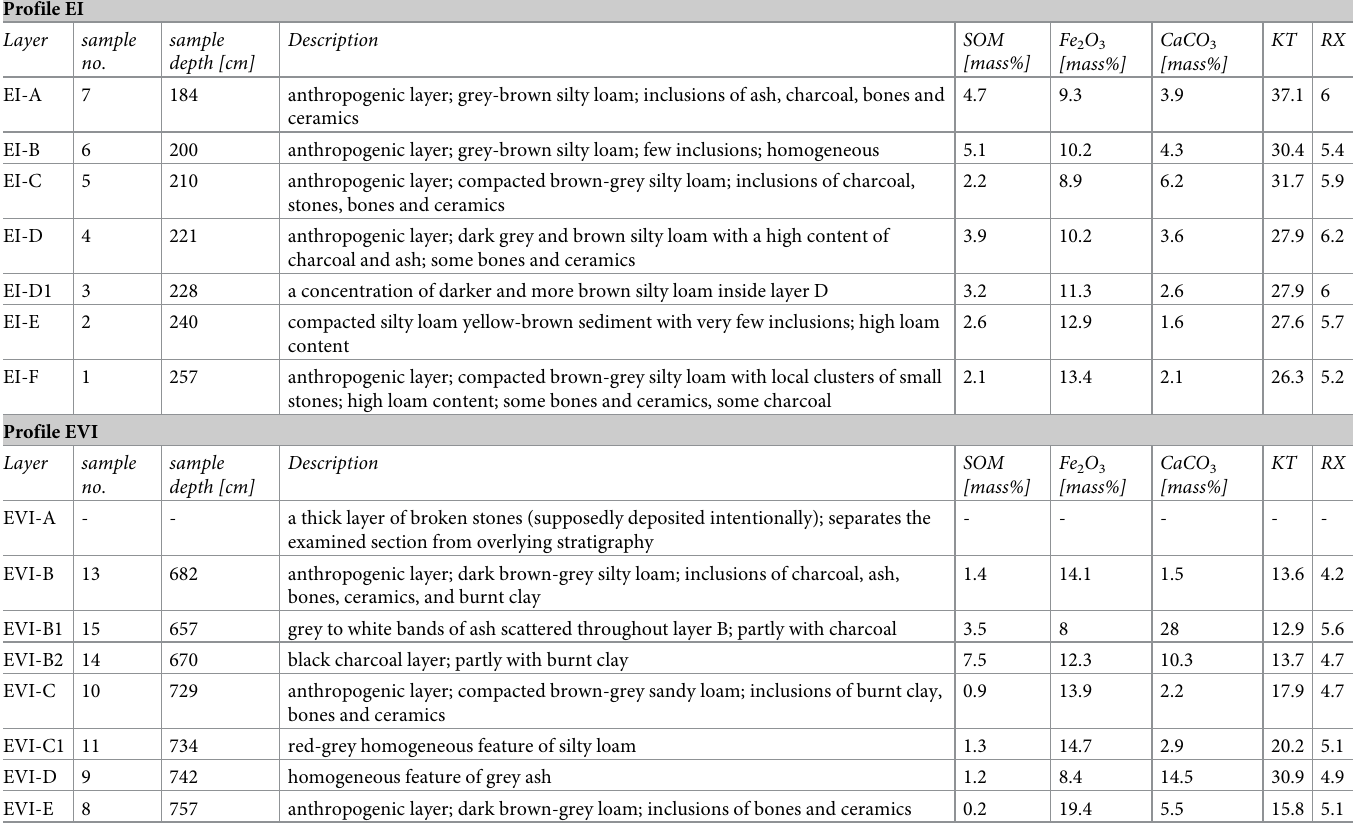
Table 1. Stratigraphic layers of profiles EI and EVI. Selected sediment properties obtained from the sampled materials (KT: K-Ti-ratio; RX: Ruxton-ratio). Depth of sam- ples given in cm below the modern surface. See S1 Fig and S1 and S2 Files for the detailed sedimentological record. Profile EI Layer sample no